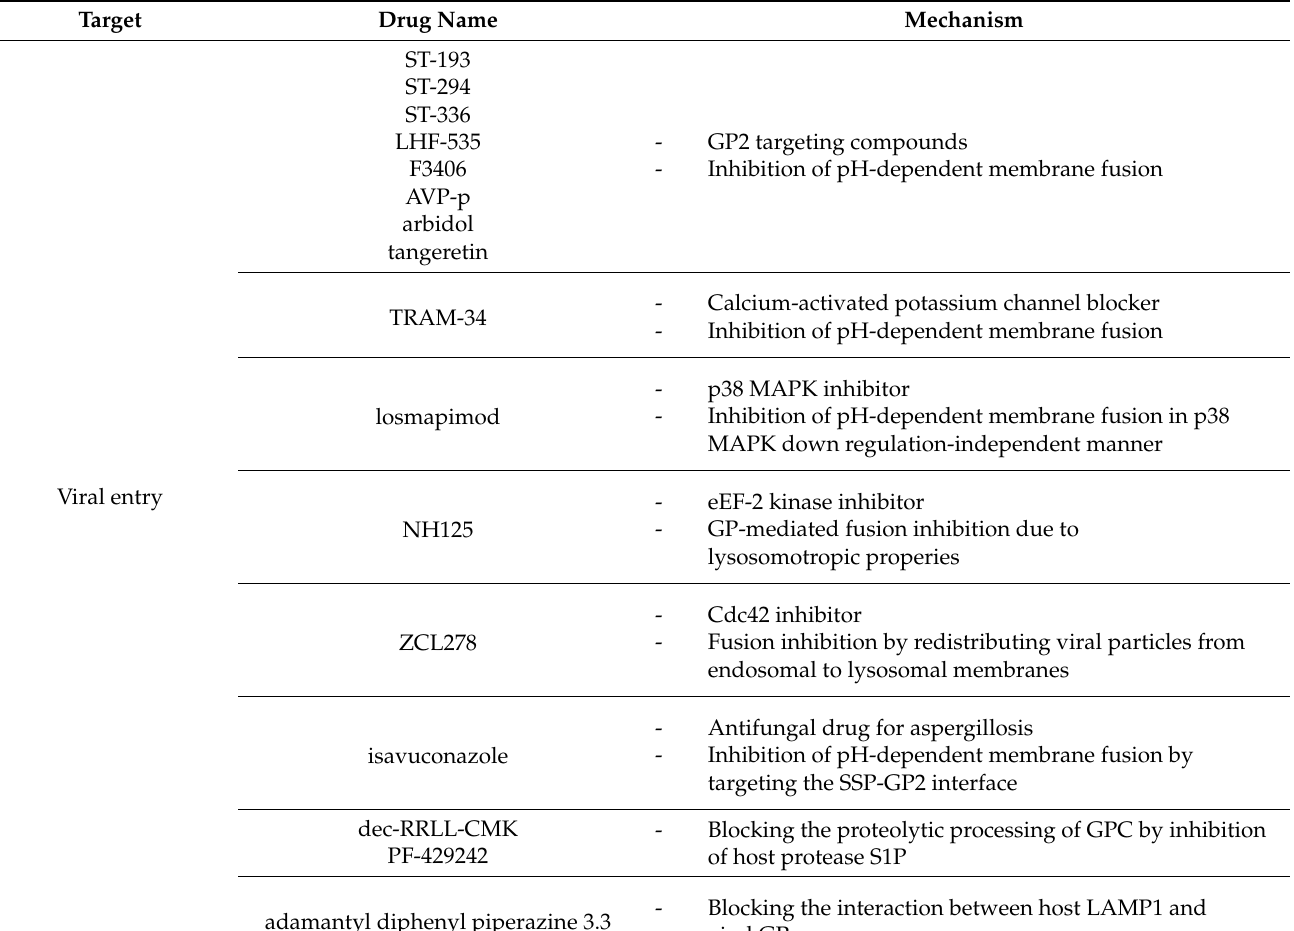
Table 1. Drugs with anti-mammarenaviral